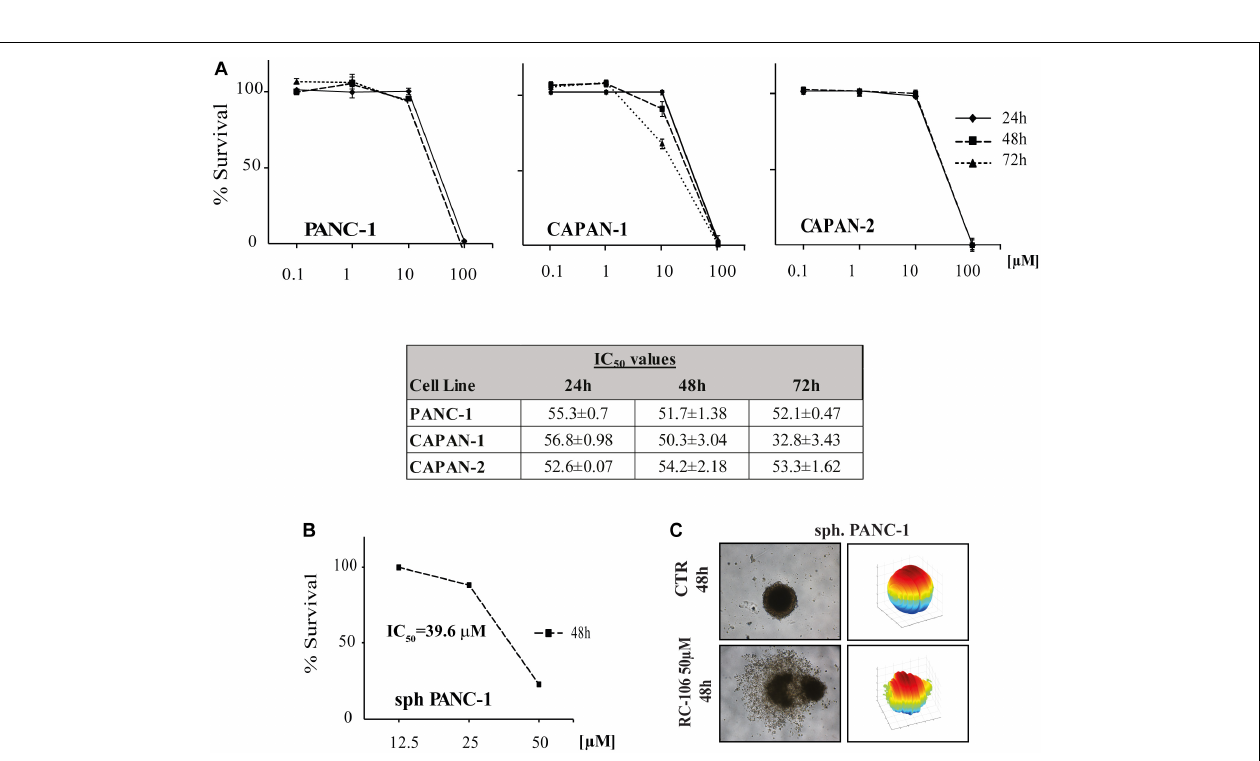
FIGURE 2 | Cell viability of 2D and 3D cell lines. (A) In vitro cytotoxic activity of RC-106 was evaluated in three PC cell lines. Cells were exposed to increasing concentration of the molecule for 24, 48, and 72 h. MTS assay was used to determine cell viability. Values are the mean ± SD of three independent experiments. (B) Homogeneous-size and shape pancreatic adenocarcinoma spheroids were treated with RC-106 for 48 h at concentration ranging from 12.5 to 50 µ M. Cell viability was measured using CellTiter-Glo 3D assay. (C) 3D spheroids shape reconstructed on representative brightfield images of Panc-1 spheroids treated with 50 µ M of RC-106 for 48 h. The corresponding 3D-shape of Panc-1 spheroids were obtained using ReViSM software tools.